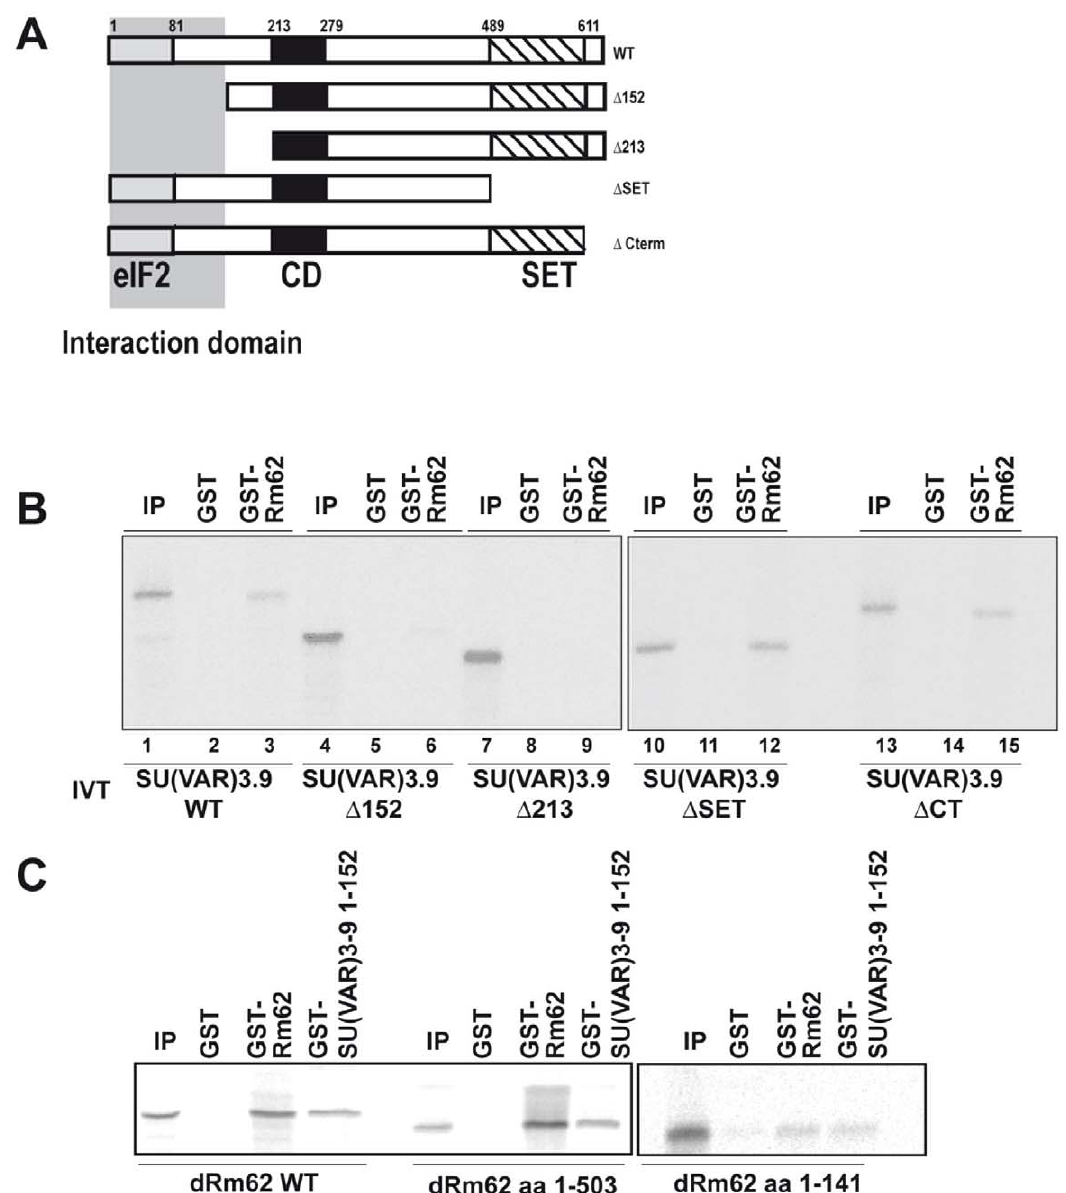
Figure 2. Mapping of the interaction domain between SU(VAR)3-9 and Rm62. ( A ) Schematic display of the in vitro translated SU(VAR)3-9 proteins. ( B ) The various in vitro translated SU(VAR)3-9 constructs were incubated with GST (GST) or a GST-Rm62 fusion protein to map the interaction domain. ( C ) In a reciprocal experiment GST-Rm62 and a GST-SU(VAR)3-9 containing only the 152 N-terminal amino acids were used as baits for in vitro translated Rm62.